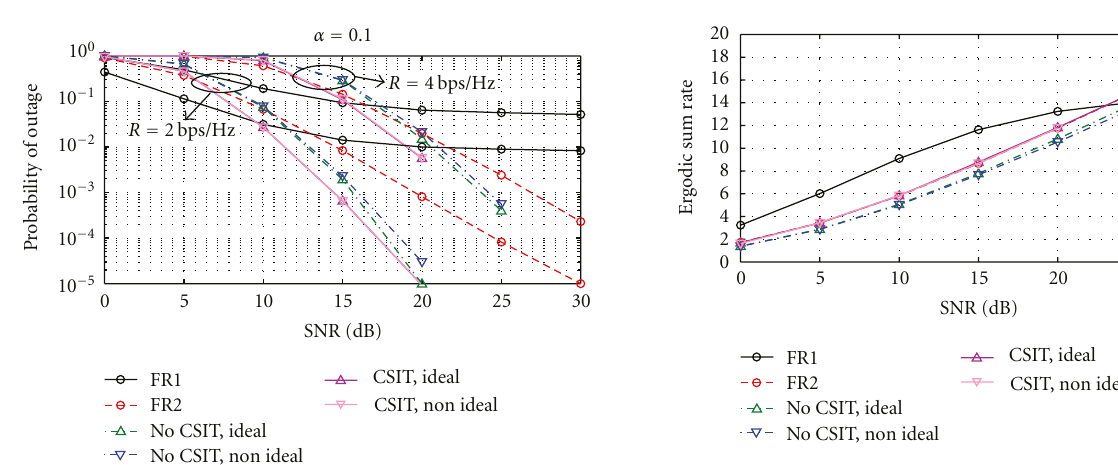
Figure 4: Average sum rate of M 0 and M 1 , as a function of the SNR (dB), for two isolated base stations. The link quality is α = 0 . 1. The non ideal link denotes the case when the base station-to-base station link gain is β = α .